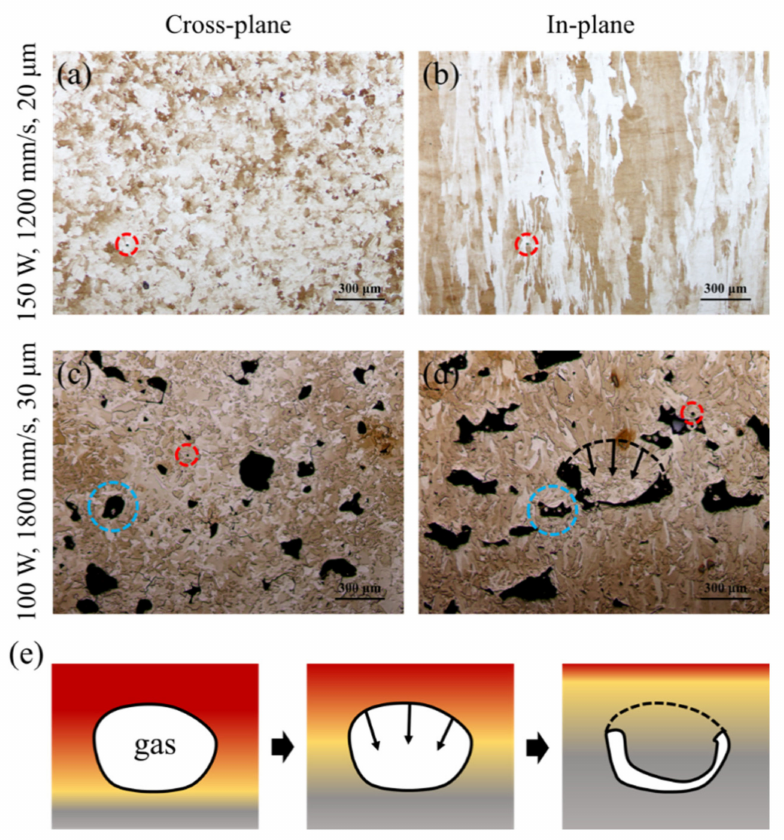
Figure 6. OM images of sample fabricated with laser power 150 W, scan speed 1200 mm/s, and layer thickness 20 µ m ( a ) cross-plane and ( b ) in-plane; images of sample fabricated with laser power 100 W, scan speed 1800 mm/s, and layer thickness 30 µ m ( c ) cross-plane and ( d ) in-plane; ( e ) schematic diagram of irregular pore